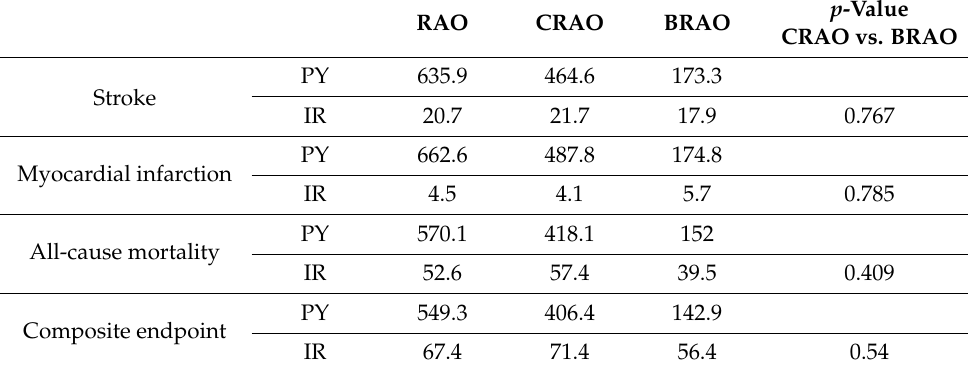
Table 2. Persons-years and the incident rate for the analyzed